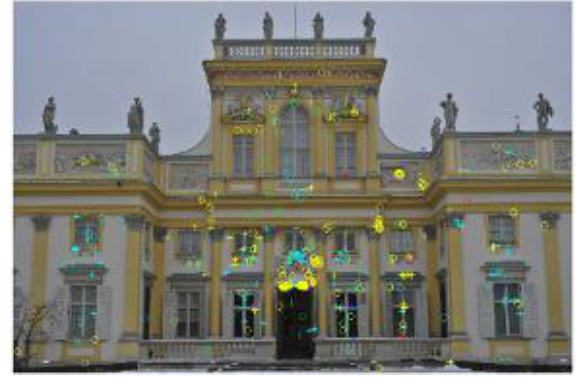
Figure 4. One of the images with superimposed points used in the calibration process.